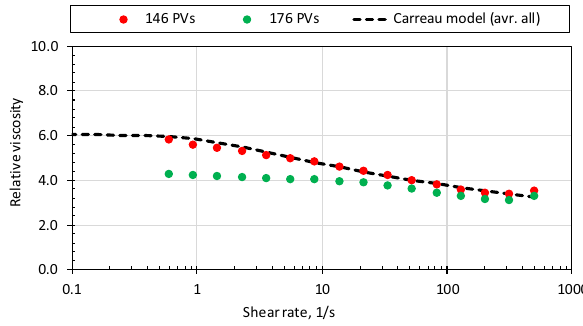
Fig. 17 Relative viscosity as a function of shear rate for 1000 ppm A10 in 3xSSW for the sample refilled at 146 PV and 176 PV in Experi- ment 8. The dashed line represents the Carreau model for the aver- age of all 1000 ppm A10 in 3xSSW samples